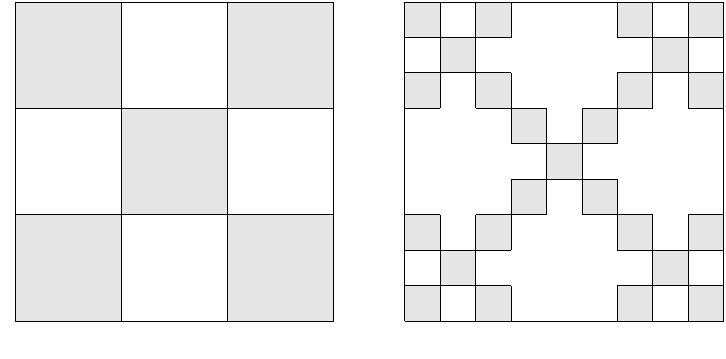
Fig. 3. Vertices considered in the unit